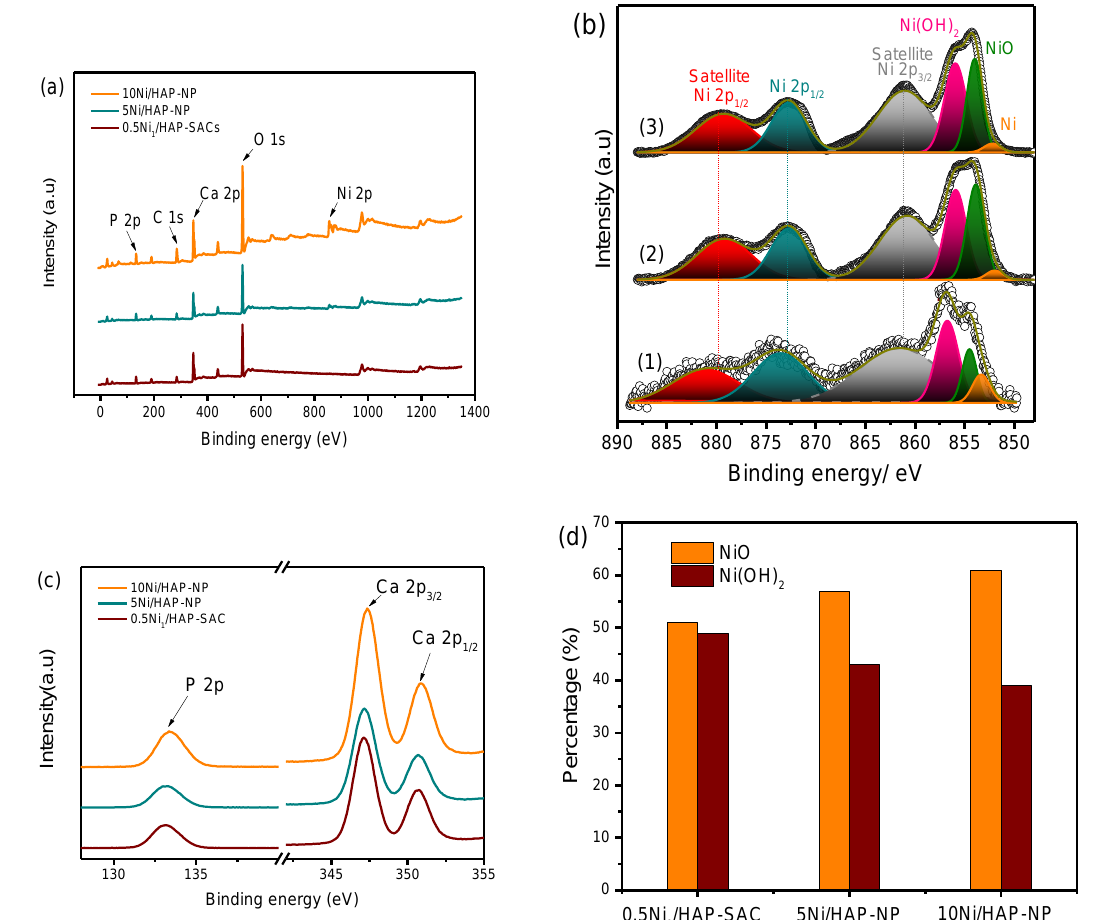
Figure 2. ( a ) The survey XP spectra of Ni / HAP catalysts; ( b ) High resolution Ni 2p XP spectra of Ex-situ reduced ( 1 ) 0.5Ni 1 / HAP-SAC, ( 2 ) 5Ni / HAP-NP, and ( 3 ) 10Ni / HAP-NP; ( c ) High resolution P 2p and Ca 2p XP spectra of ex situ reduced samples; ( d ) NiO and Ni(OH) 2 percentage as a function of Ni loading.